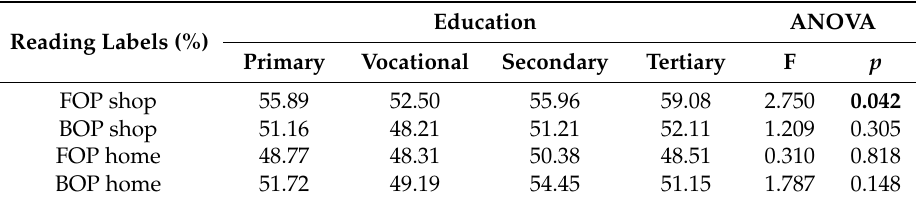
Table 4. Reading food labels by education.